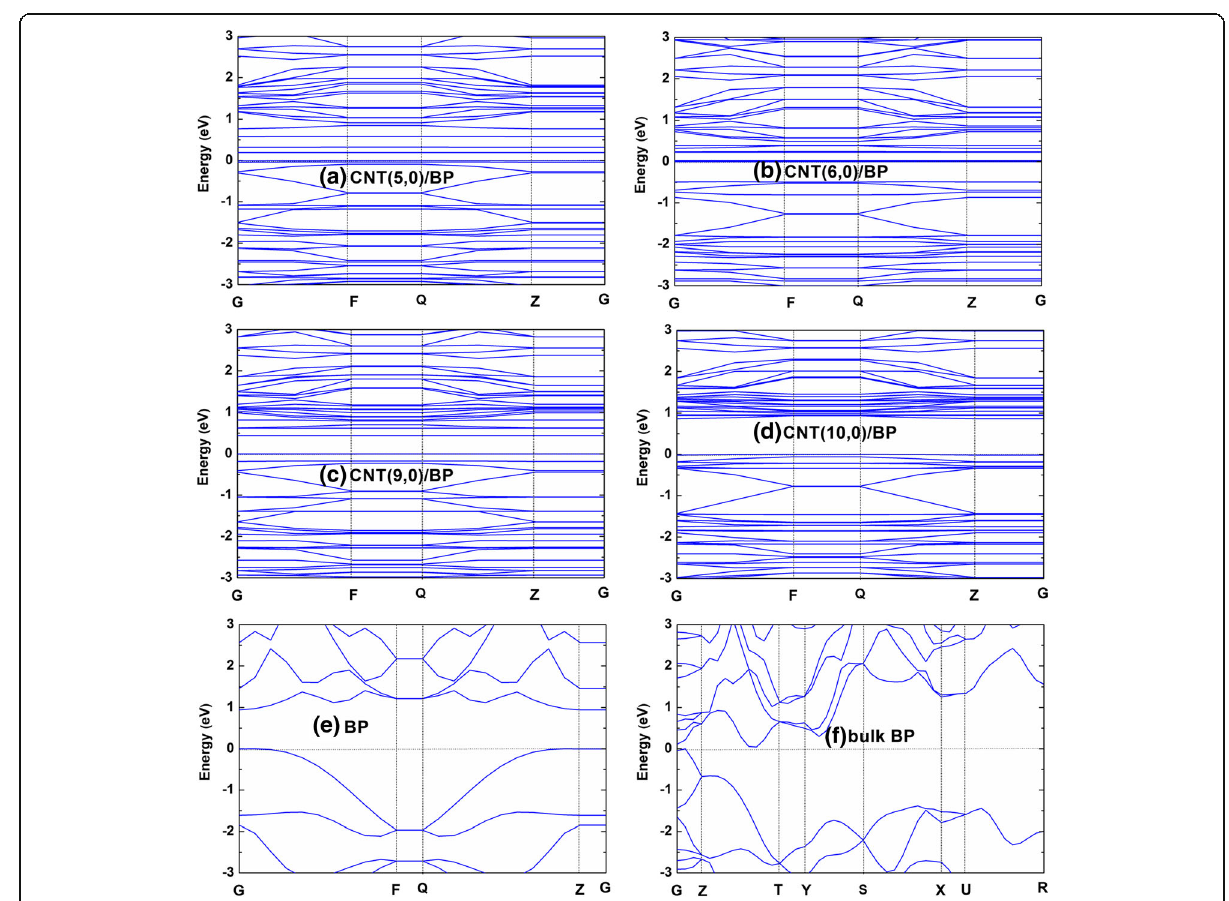
Fig. 2 Band structures for the hybrids a CNT(5,0)/BP, b CNT(6,0)/BP, c CNT(9,0)/BP, d CNT(10,0)/BP, e monolayer BP, f bulk BP, respectively. The horizontal dashed line is Fermi